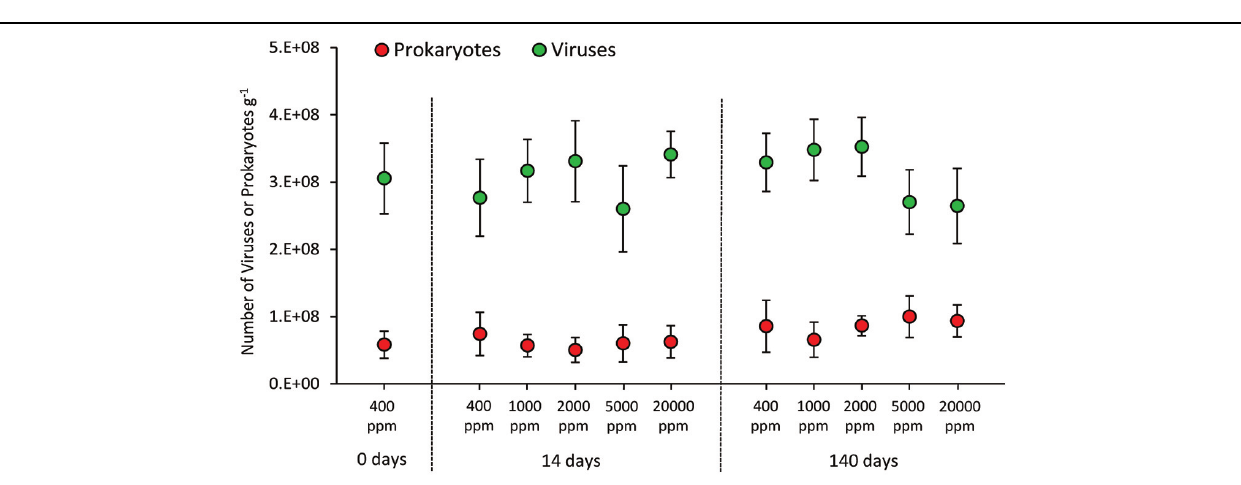
FIGURE 3 | Total abundance of prokaryotes and viruses in the different high-CO 2 experimental systems (1,000–20,000 ppm) and in the controls (i.e., 400 ppm), showing mean and SDs